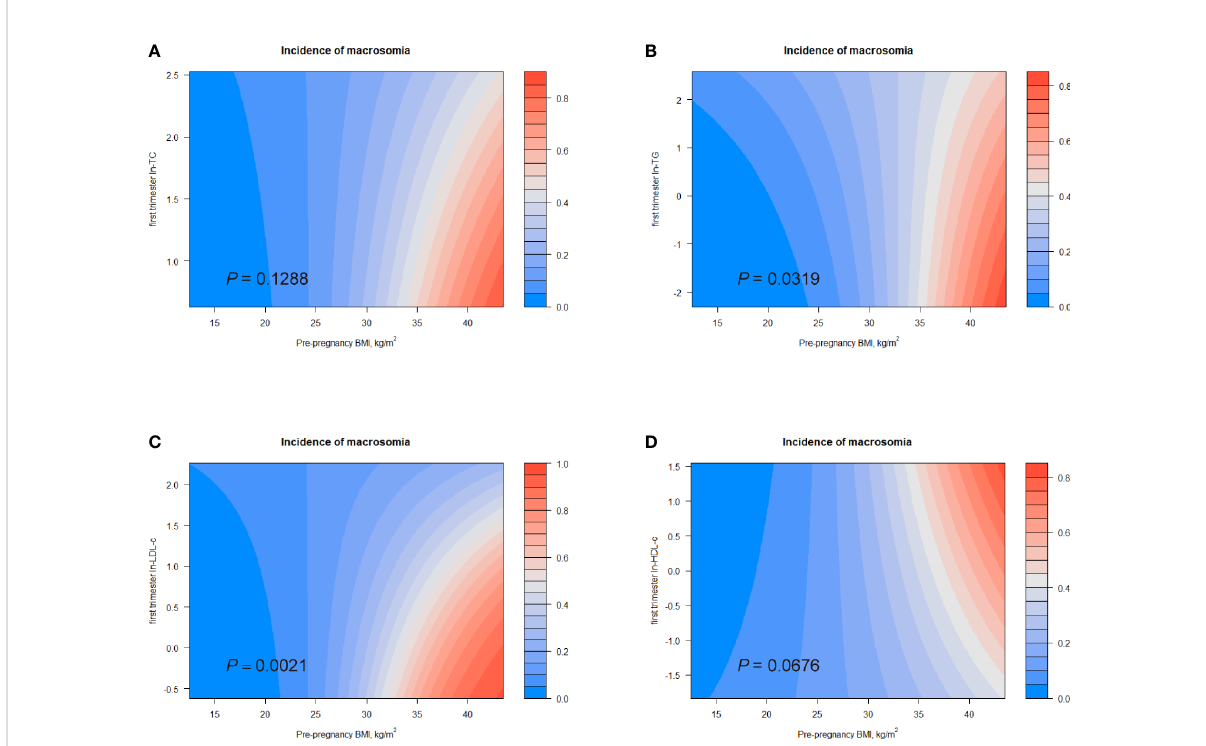
FIGURE 5 Combined effects of maternal pre-pregnancy BMI and lipid pro fi les in early pregnancy on incidence of macrosomia. Heat map for the correlation ofincidence ofmacrosomia (red represents increasedrisksof LGA, blue represents decreased risks of LGA) according to the interaction of pre-pregnancy BMI and (A) ln-TC, (B) ln-TG, (C) ln-LDL-c, or (D) ln-HDL-c. Analyses wereadjusted for maternal pre-pregnancyBMI,age, mode of conception, parity, education, consumptionof cigarettes, infant sex, gestational diabetes, and gestational hypertension